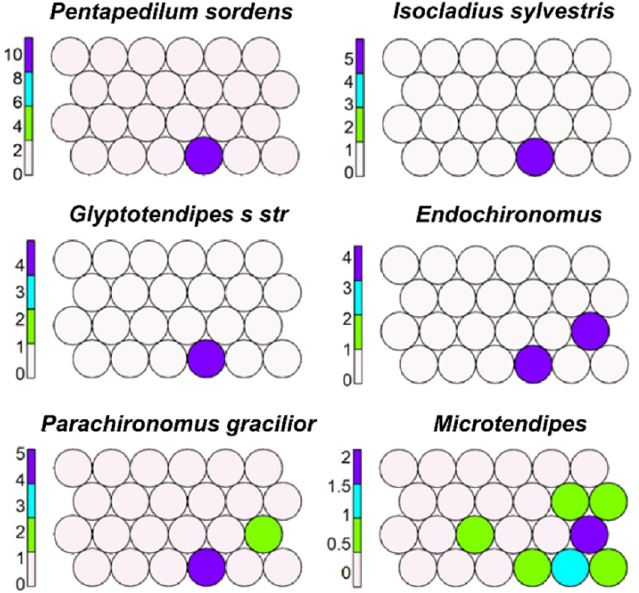
Figure 6. Unsupervised map of six morphotaxa associated with vegetation.